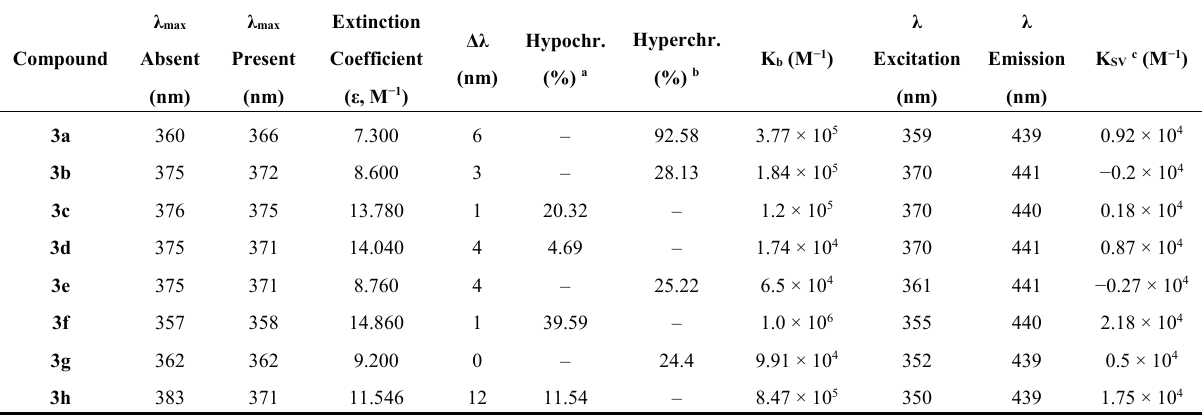
Figure 1. Absorption spectra of derivative 3a (50 µM) with increasing concentrations of calf thymus DNA (ctDNA). [DNA] = 0, 10, 20, 40, 60, 80, 100 and 120 µM. Arrows ( ↑ ) and ( → ) refer to hyperchromic, and bathchromic effects, respectively. Inset: Plot of [DNA]/( ε a − ε f ) as function of DNA concentration as determined from the absorption spectral data. Table 1. UV–Vis absorption and fluorescence emission data of new acridine-thiosemicarbazone derivatives in the absence and presence of